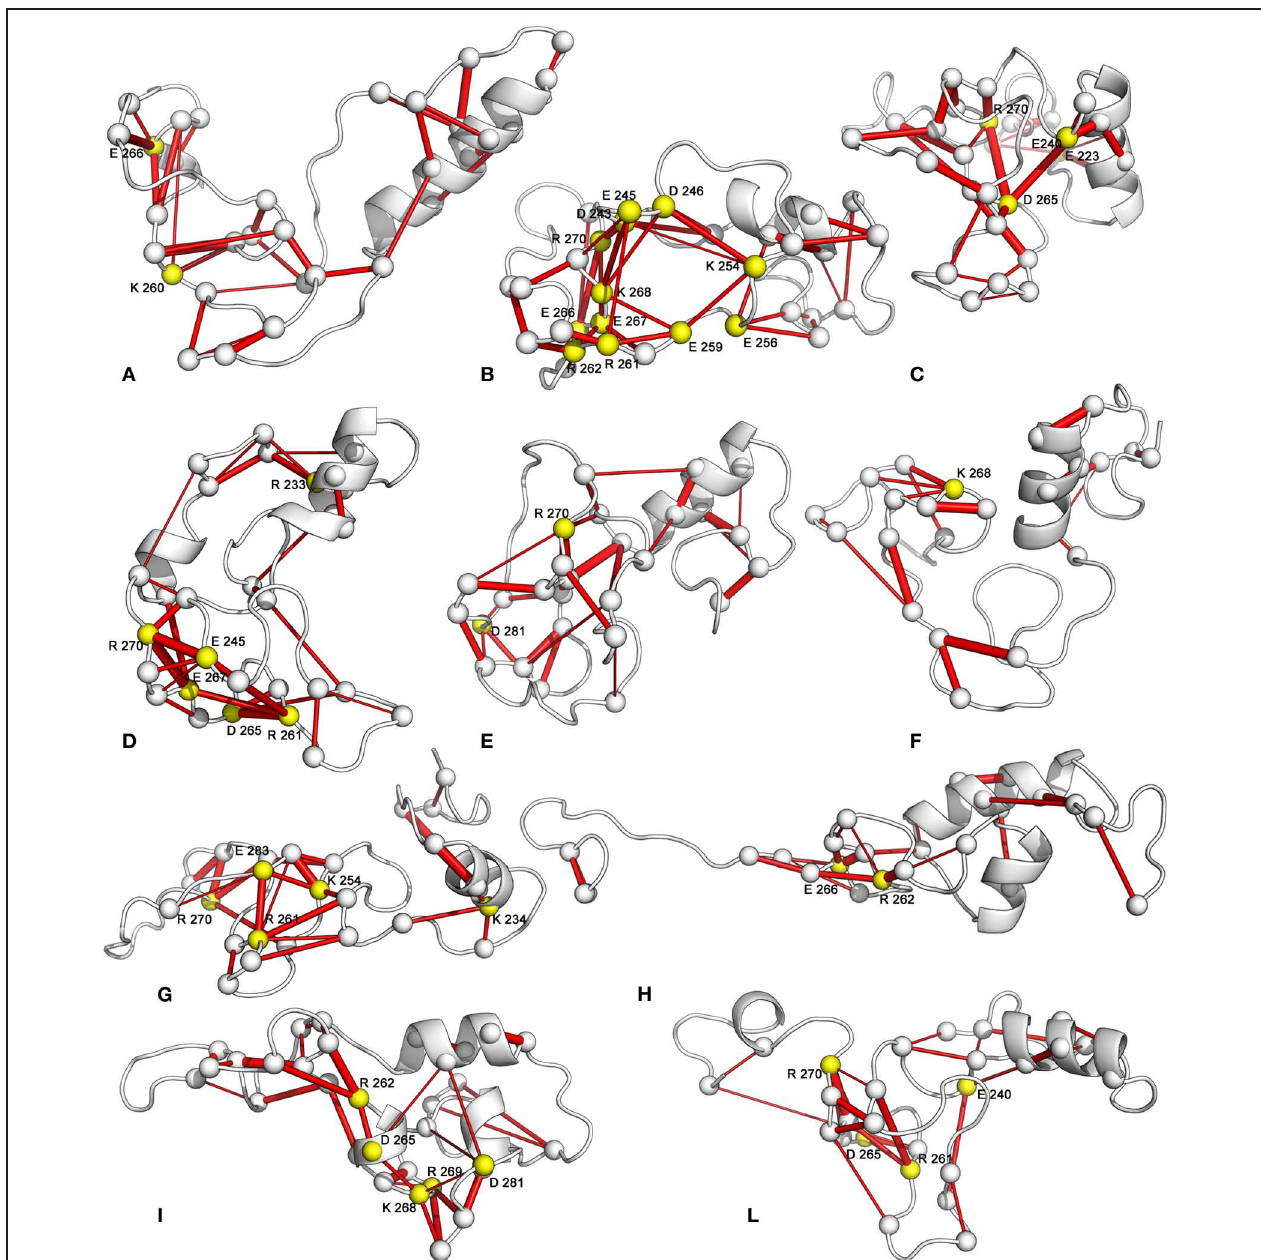
FIGURE 10 | Hub residues in salt-bridge networks. The 3D average structure of each FEL basin is shown as cartoon, and the C α atoms of the residues involved in salt bridges are shown as spheres. The C α atoms of the